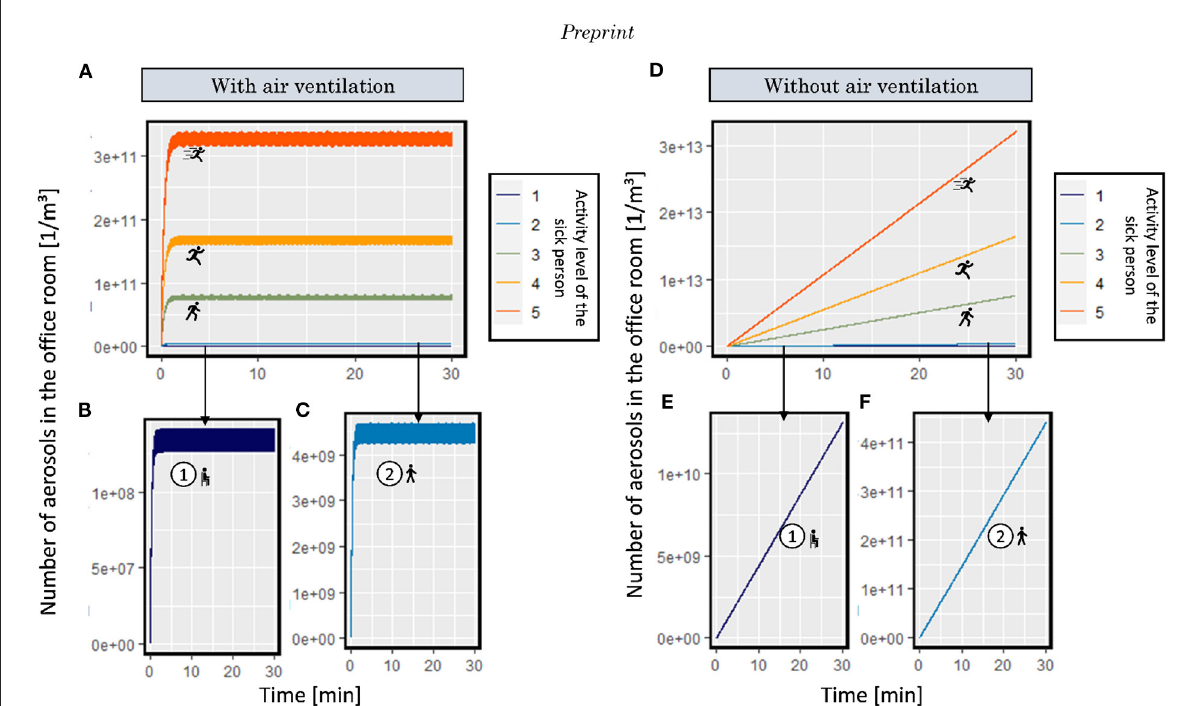
FIGURE4 (A) Number of emitted aerosol in the office room with air ventilation during 30min by 5 different activity levels; (B) activity level 1; (C) activity level 2; (D) Number of emitted aerosol in the office room without air ventilation during 30min by five different activity levels; (E) activity level 1; (F) activity level 2, with no mask (the icons are from